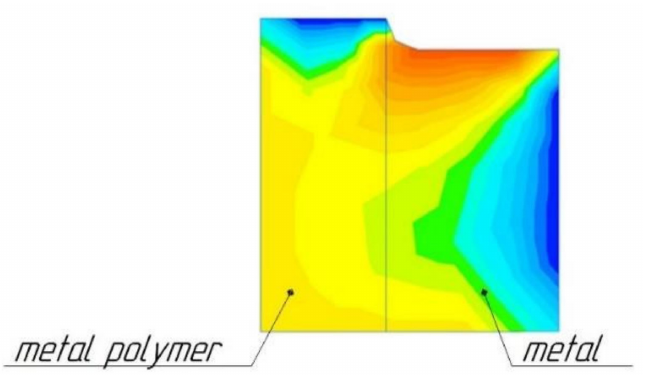
Figure 15. Diagram of the distribution of temperature fields from metal to metal-polymer during grinding, Reprinted from [18], Taylor and Francis group, Copyrights 2022,